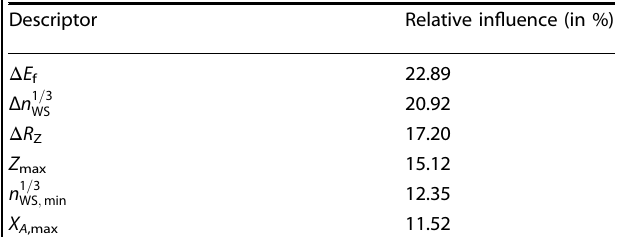
Table 1. The six descriptors in r-MART model and their